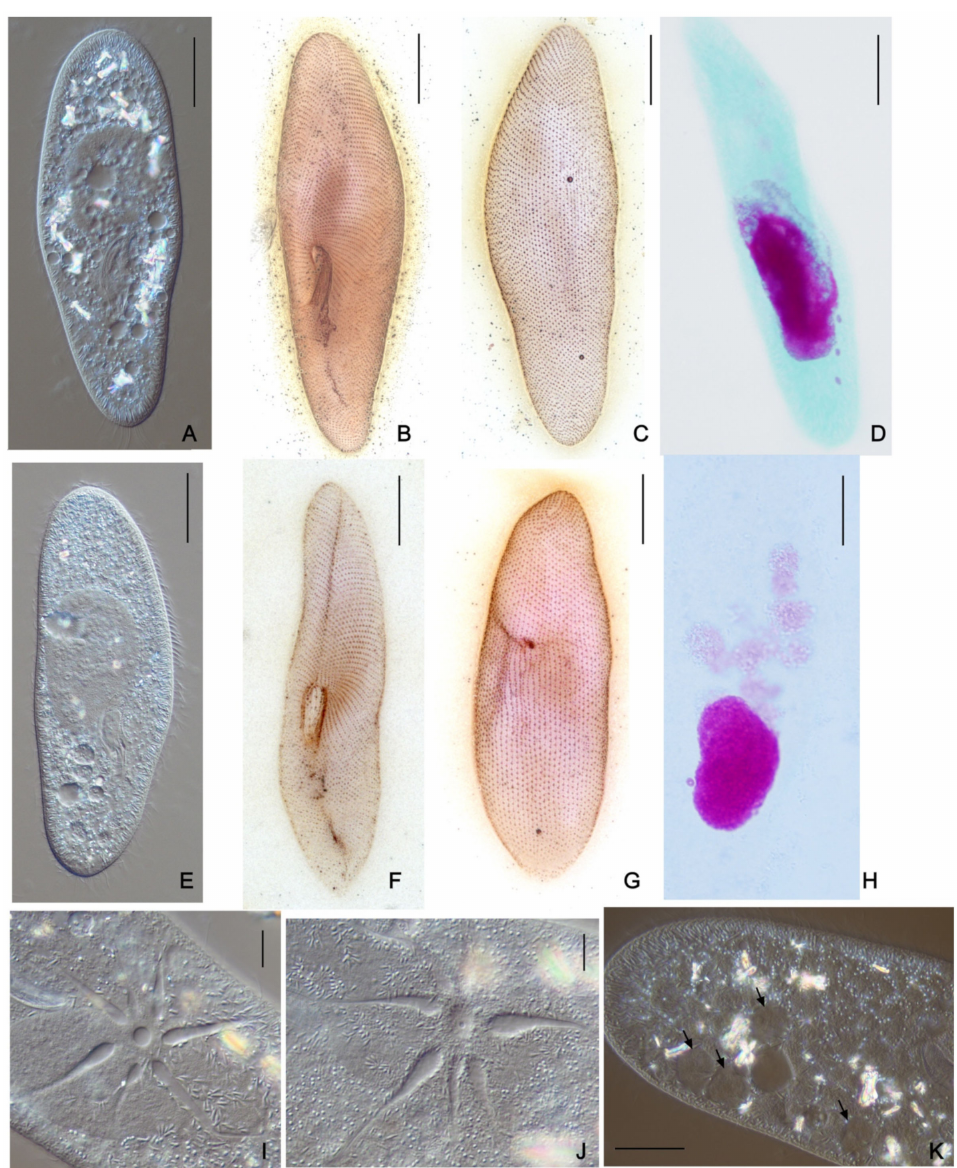
Figure 7. Morphological features of Paramecium multimicronucleatum and P. fokini n. sp. Strains of P. multimicronucleatum : ( A ) DIC live micrograph of a specimen. ( B , C ) Silver nitrate impregnated cells: ventro-lateral and dorso-lateral cell projections; ( D ) Feulgen stained specimen with three MICs. Strains of P. fokini n. sp.: ( E ) DIC live micrograph of a specimen. ( F , G ) Silver nitrate impregnated cells: ventro-lateral and dorso-lateral cell projections; ( H ) Feulgen stained specimen with two MICs. Contractile vacuoles of both species ( I , J ) are very similar. ( K ) DIC live micrograph showing the exconjugant cell of a strain of P. fokini n. sp.; four MAC anlagen are marked with the arrows. Scale bars: 20 µ m ( A – D ) and 4 µ m ( E – I